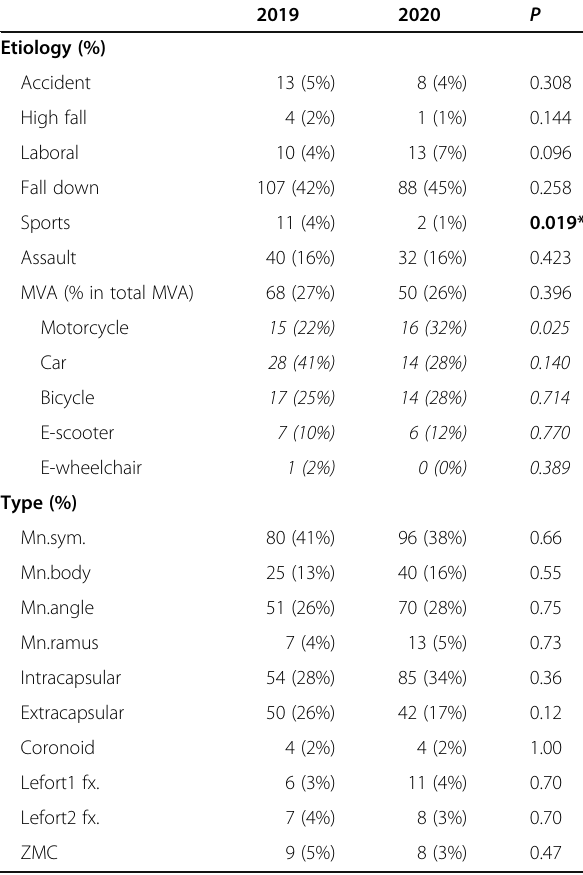
Table 2 Etiology and type of oral and maxillofacial fracture patients during 2020 versus